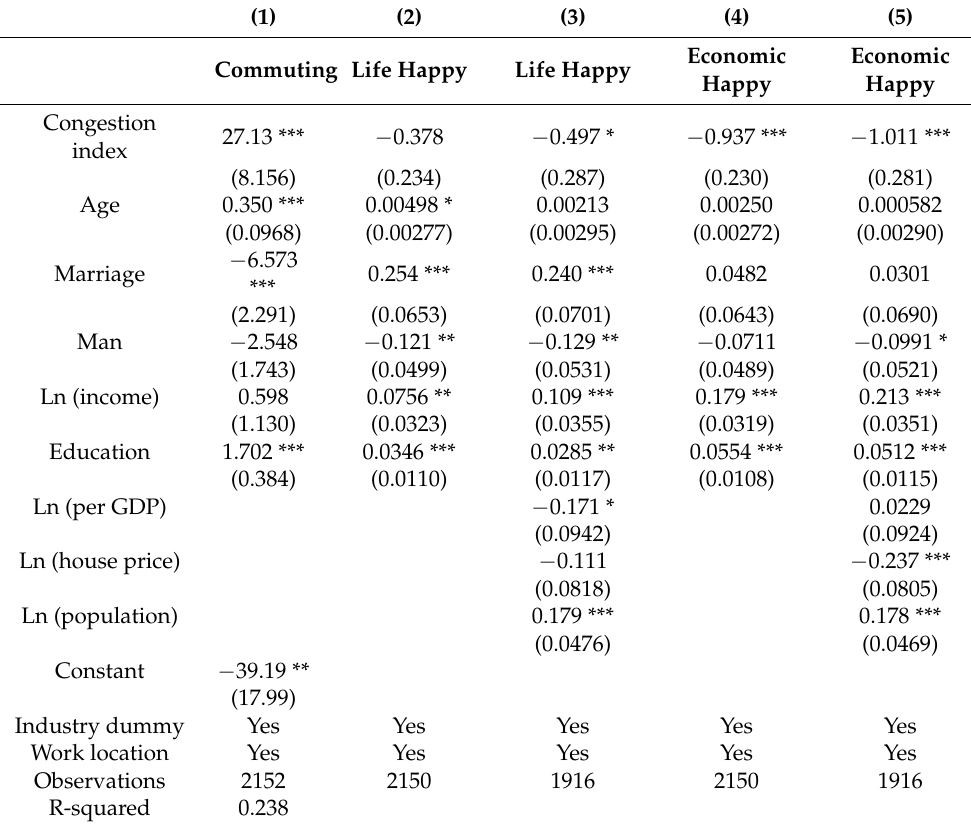
Table 5. Congestion and quality of